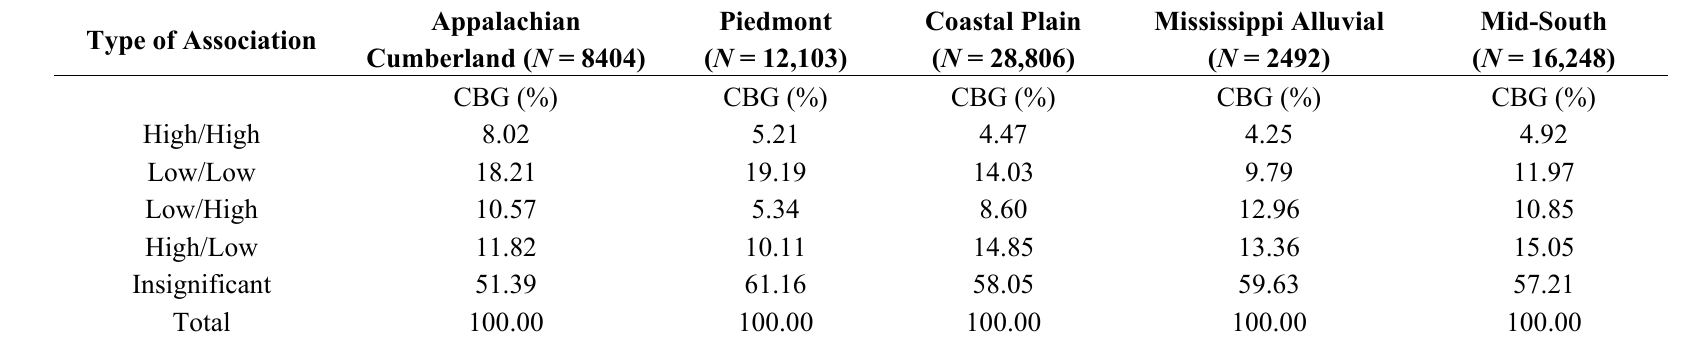
Table 4. Distribution of LISA Clusters by Ecoregion—Winter.